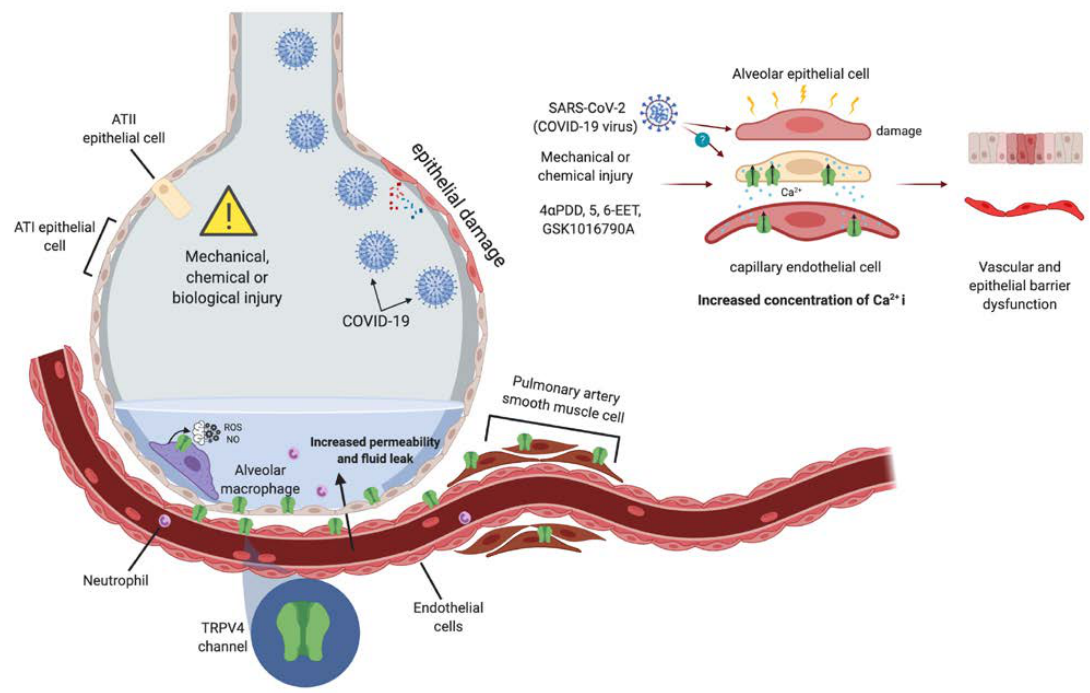
Figure 3. TRPV4 and lung damage. Stimuli such as the exposure to chemicals or mechanical stress (induced by liquids or a ventilator), lead to failure in the function of the alveolo-capillary (endothelial and epithelial cells) barrier with a consequent increase in their permeability, allowing for build-up of liquids in the alveoli. In addition to this, activation of TRPV4 in the alveolar macrophages results in an increase in intracellular Ca 2+ and in the production of superoxide and nitric oxide (NO). Recently, the SARS-CoV-2 (severe acute respiratory syndrome coronavirus 2) was identified and shown to cause the COVID-19 (coronavirus disease 19) that affects epithelial cells (type I and II) of the alveoli, promoting edema. TRPV4 could be involved in the inflammatory response caused by the SARS-CoV-2 virus. Since TRPV4 overactivation or overexpression can lead to damage in the alveolo-capillary barrier, it has been proposed that inhibitors of TRPV4 could result in a better outcome for COVID-19 patients [147] , alveolar epithelial type I and II (ATI and ATII), 4α -phorbol 12,13- didecanoate (4αPDD) and 5, 6 -epoxyeicosatrienoic acid (5, 6-EET). ROS, reactive oxygen species. Created with Biorender.com.